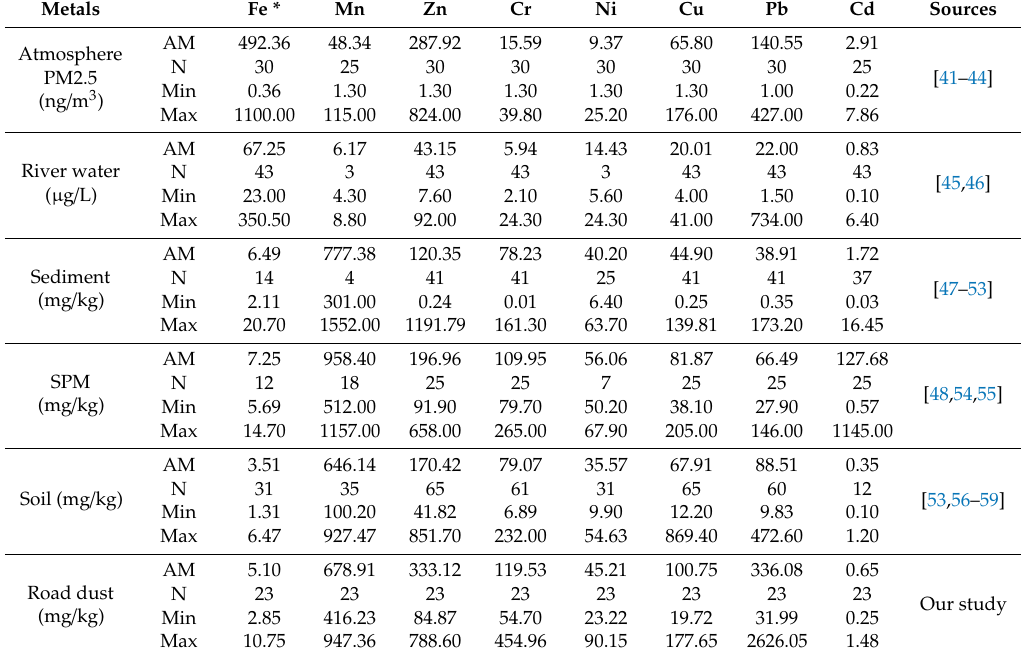
Table 1. Summary of the observed concentration of metals in multimedia in